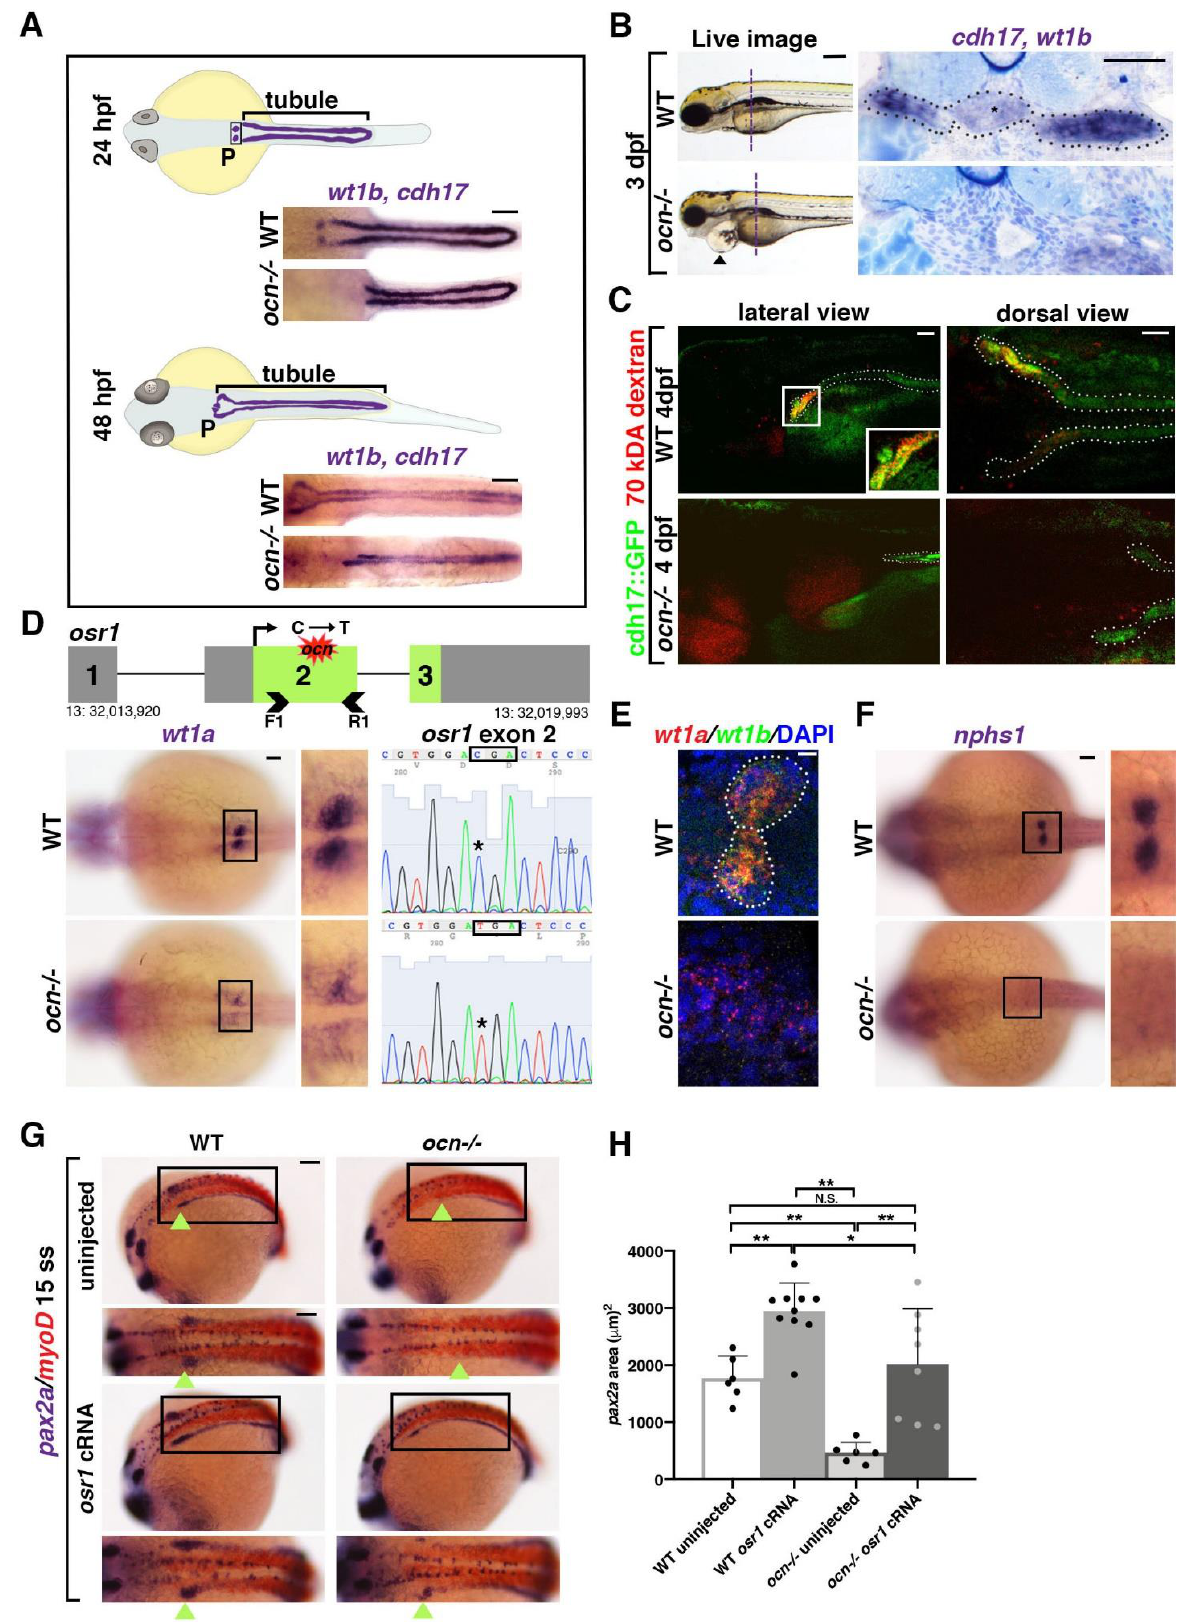
Figure 1. The ENU mutant ocn has a proximally abrogated pronephros due to a lesion in the gene osr1 . ( A ) At 24 hpf, the zebrafish pronephros contains two clusters of podocytes (P) and two nephron